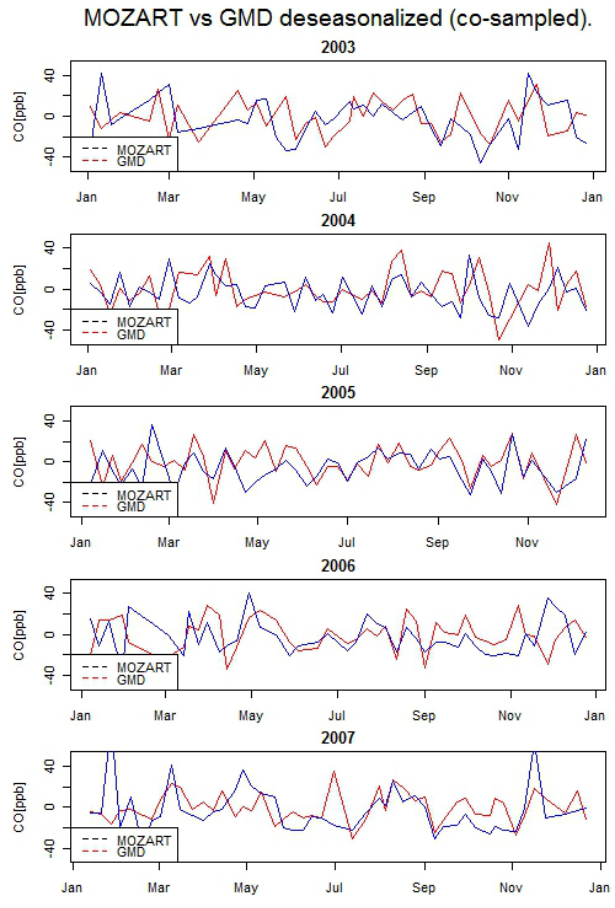
Fig. 9. A comparison between the deseasonalized time series of MOZART (blue) and GMD (red) for the years 2003-2007. The model was able to reproduce the synoptic scale variation for these years for the period between August to